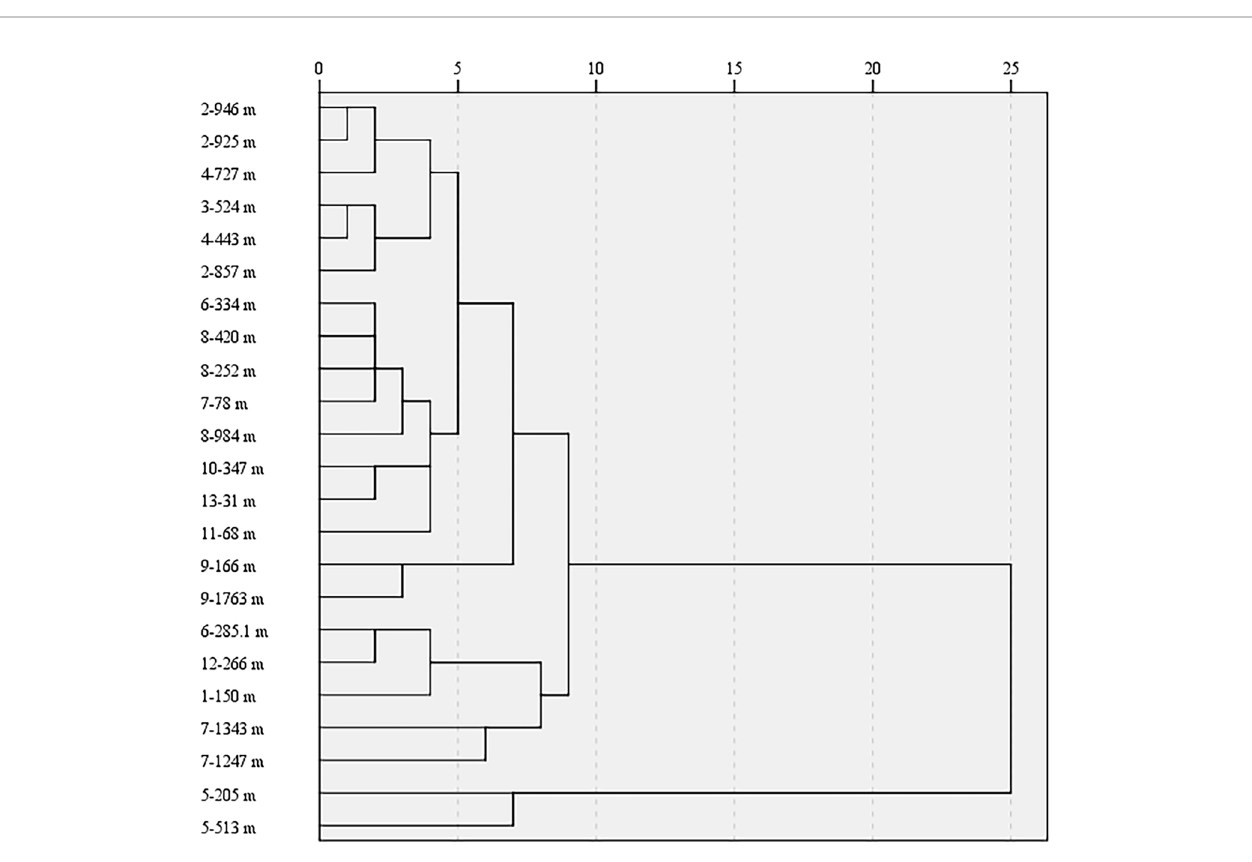
FIGURE 9 | Hierarchical cluster analysis (HCA) dendrograms of the Eucommia ulmoides leaves (EUL) samples from different regions (The hyphen is preceded by the region of EUL samples, the hyphen followed by each sample collection site